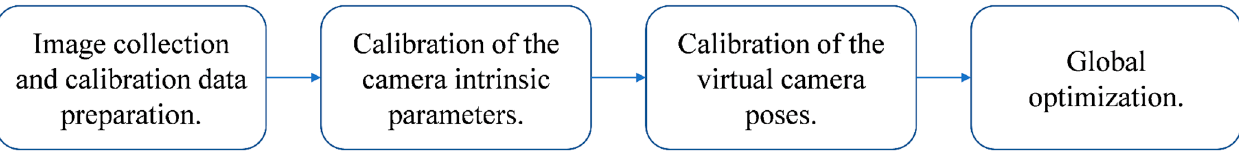
Figure 5. The main steps of the VMOS calibration.